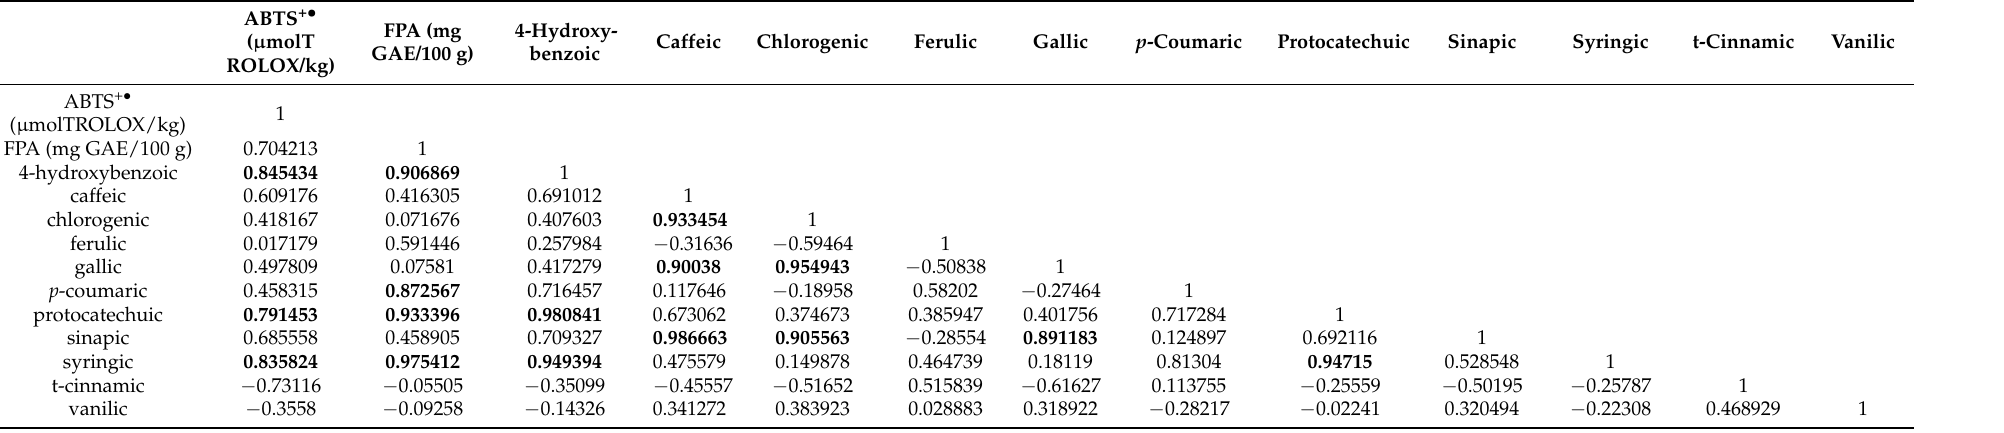
Significant correlation coefficients at the level of 0.95 were marked in